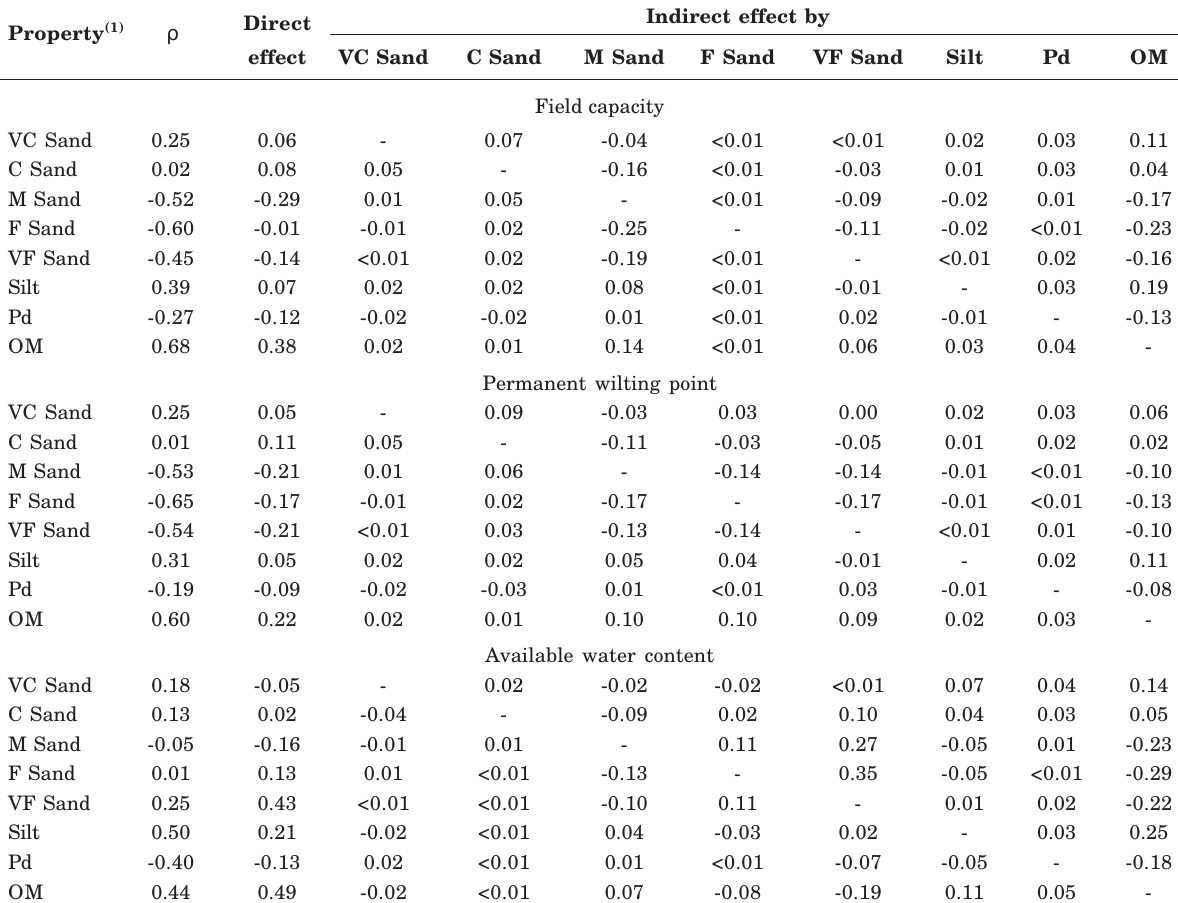
Table 4. Correlation coefficients considering the direct and indirect effects obtained through path analysis, of the sand contents (five fractions), silt and particle density (Pd) and organic matter (OM), on